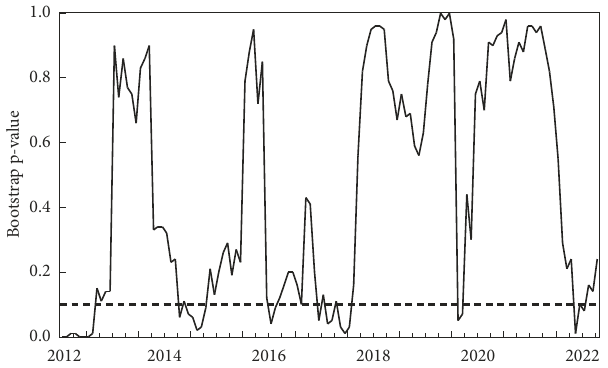
Figure 2. Examining the null hypothesis that GSCP does not Granger cause BP (source: authors’ calculations)